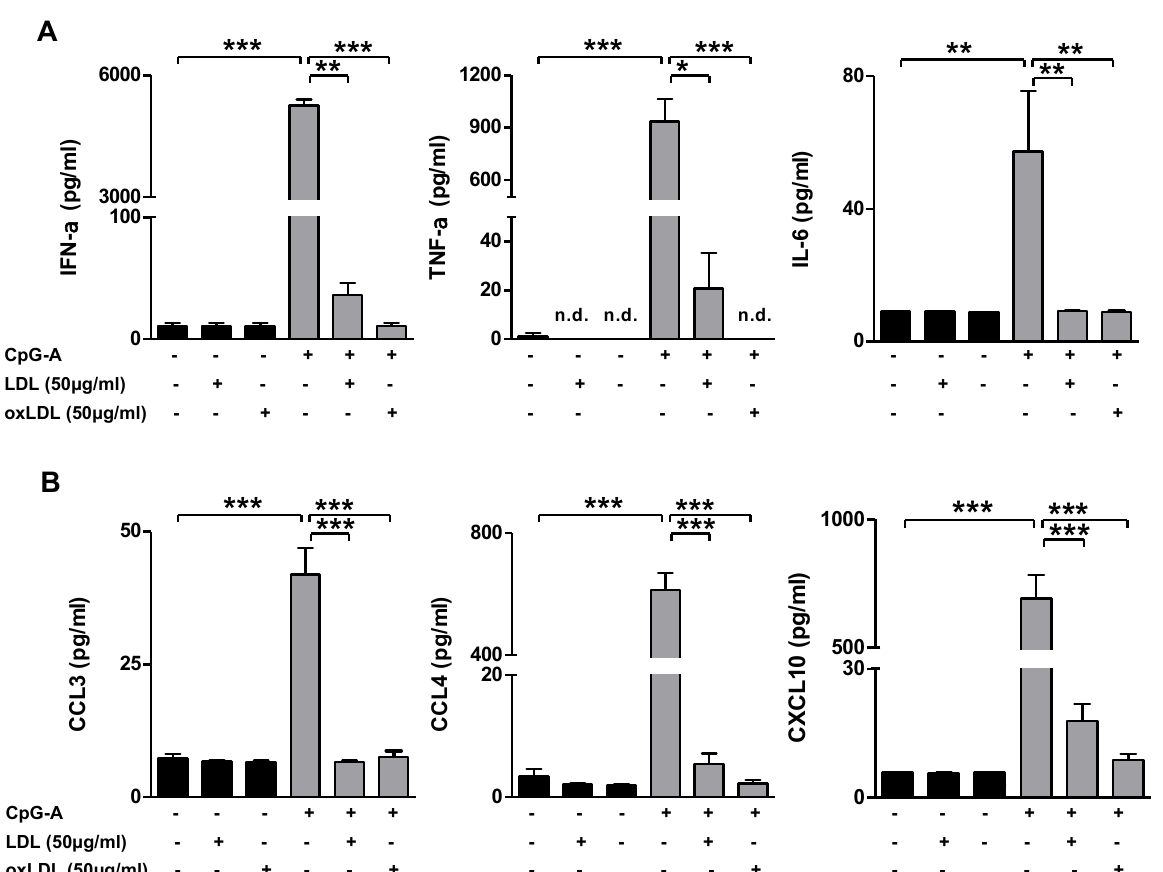
Figure 3. (Oxidized) LDL inhibits CpG-induced pro-inflammatory cytokine production by pDCs. Freshly isolated human pDCs were stimulated with 2.5 µ M CpG-A either with or without LDL (50 µ g/mL) or oxLDL (50 µ g/mL). Non-stimulated pDCs were used as control. After 24 h, cell supernatants were analyzed for the indicated cytokines ( A ) and chemokines ( B ) by use of the CBA kit. Data are shown as mean ± SEM of three independent experiments using pDC preparations from different donors. * p < 0.05; ** p < 0.01, *** p < 0.001.